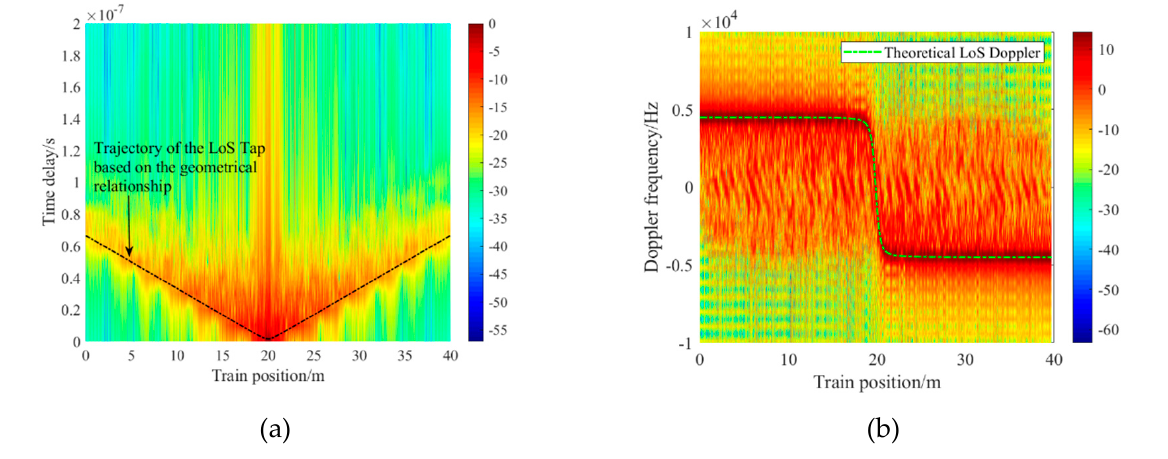
Figure 2. Wireless channel analysis results of the DAS: ( a ) the normalized CIR; ( b ) the Doppler power spectrums at different positions.